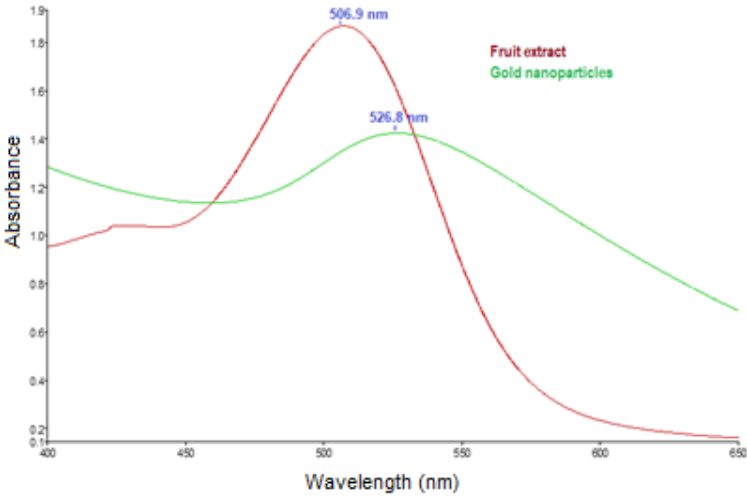
Figure 3. UV-Vis spectra of Cornus mas fruit extract and gold nanoparticles.